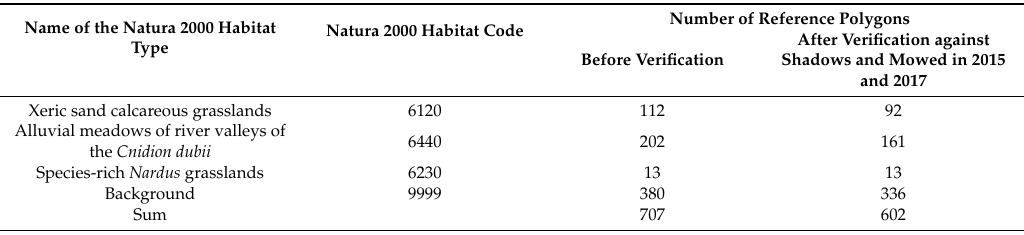
Table 4. Number of reference polygons before and after visual verification according to type of Natura 2000 habitats and